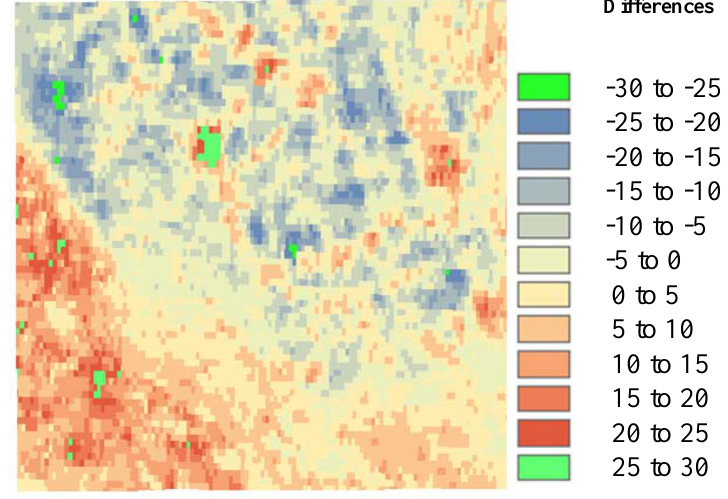
Fig 3a . . Difference between ASTER v2 and OSGB heights in Caerlaverock area. (Green pixels are those with positive or negative differences > 3 x RMSdifferences)